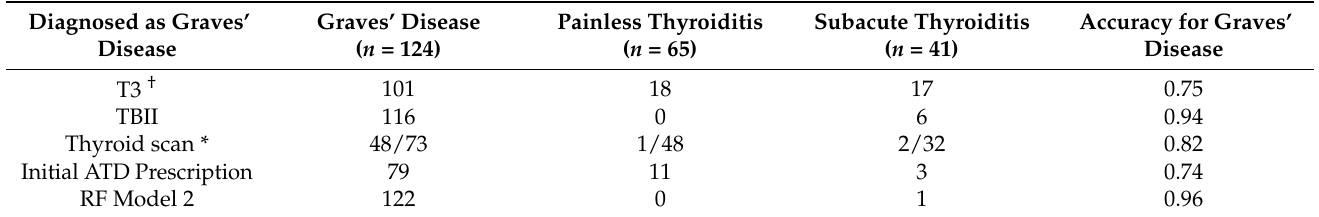
Table 3. Clinical validation comparing the standard diagnostic approach and machine learning